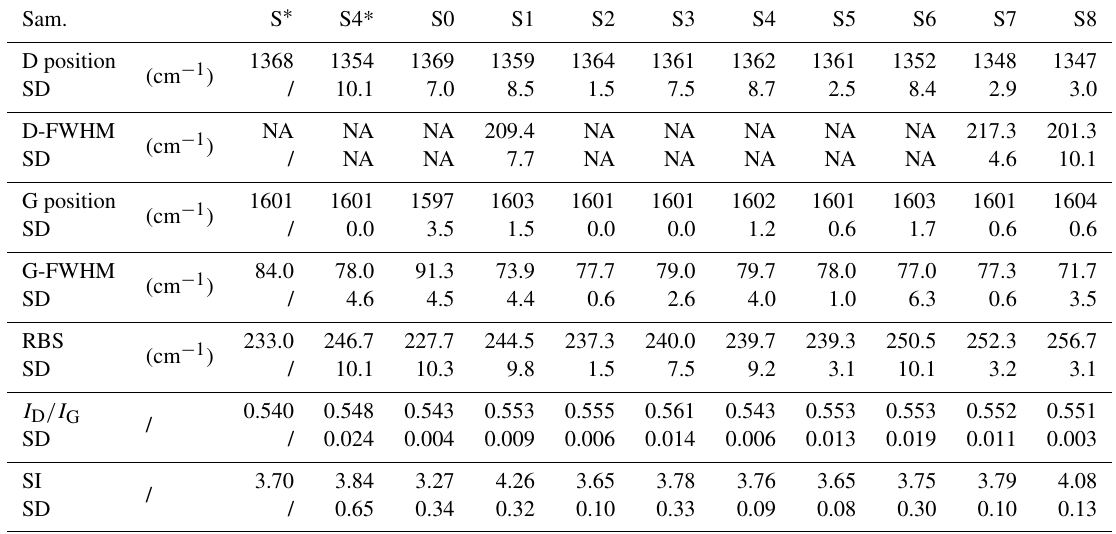
Table 4. Parameters obtained from normalized Raman spectra using the method reported by Henry et al. (2018).